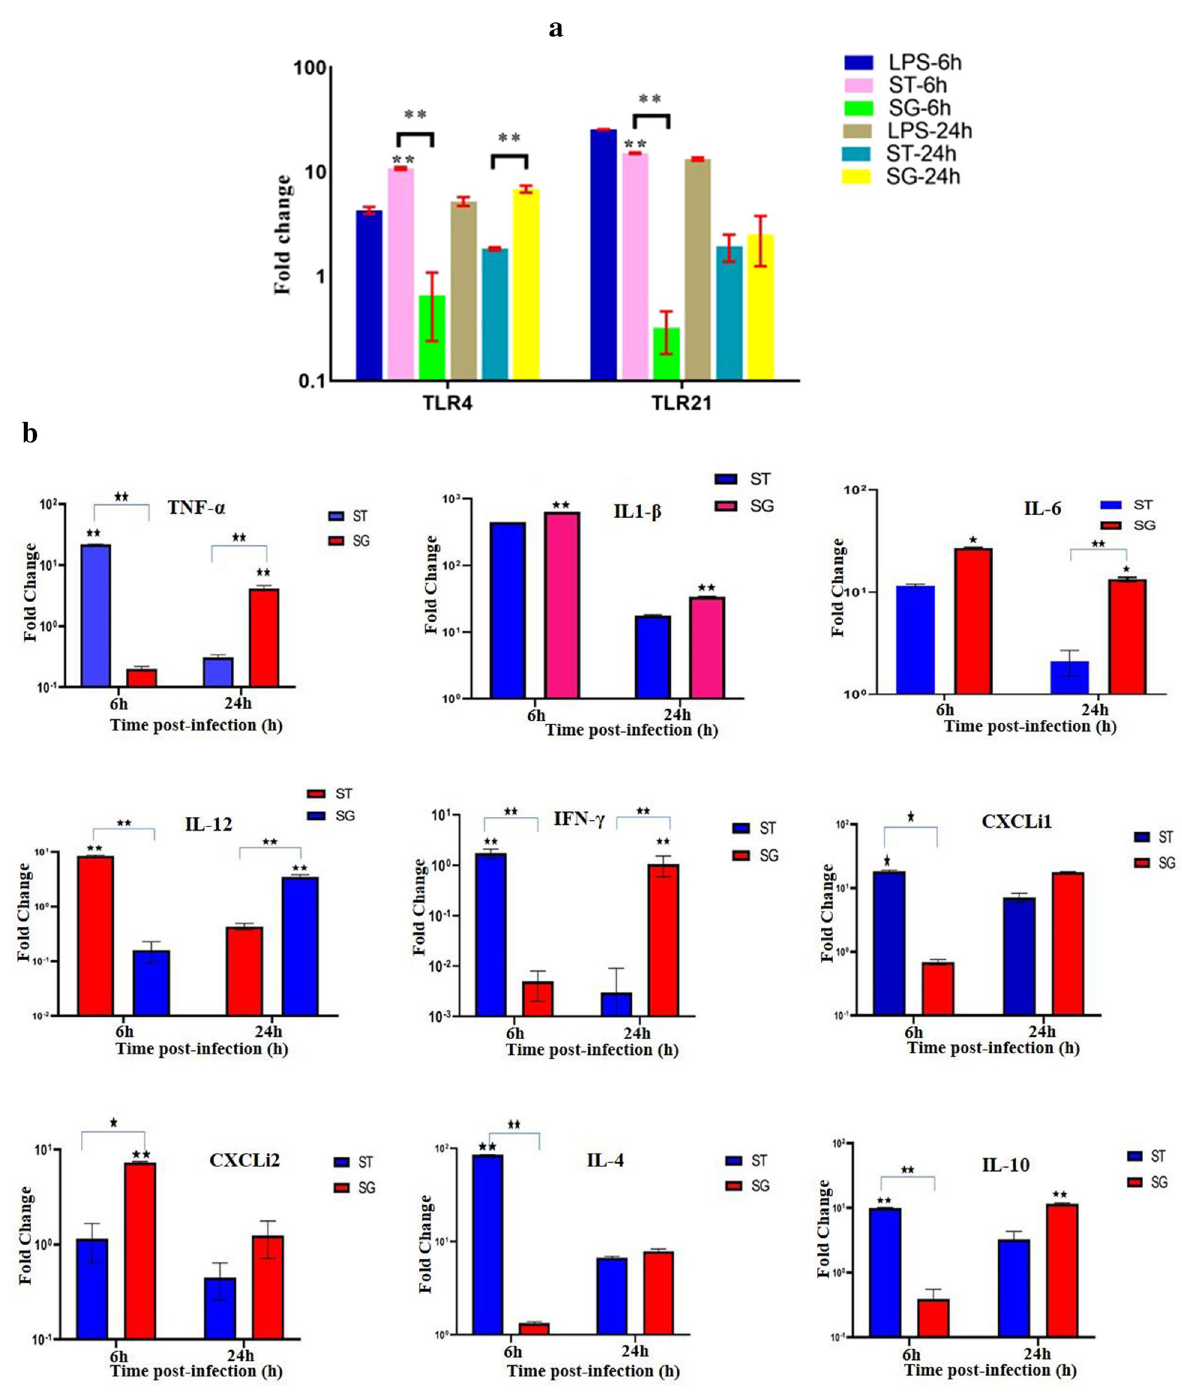
Figure 6. Expression of TLRs ( a ) and cytokines ( b ) in chMoDCs at 6 and 24 h post-infection with S . Gallinarum (SG) and S . Typhimurium (ST) (multiplicity of infection 10). The mRNA expression for pro- and anti-inflammatory cytokines, related key chemokines, and toll like receptors were determined by real time- quantitative polymerase chain reaction (RT-qPCR). The mock-infected cells were used as control for calculating the fold change of differential gene expressions in the infected cells. ( a ) Data were analysed by two-way repeat measures ANOVA for S. Typhimurium and S. Gallinarum at 6 and 24 h post-infection. LPS served as positive control but not included in the analysis. Data for negative control is not shown; ( b ) Data were analysed by two-way repeat measures ANOVA for S. Typhimurium and S. Gallinarum at 6 and 24 h post-infection. Data for negative control served as calibrator group to calculate the fold change differences. Values shown are mean ± SEM of three independent experiments ( *P < 0.05, **P <